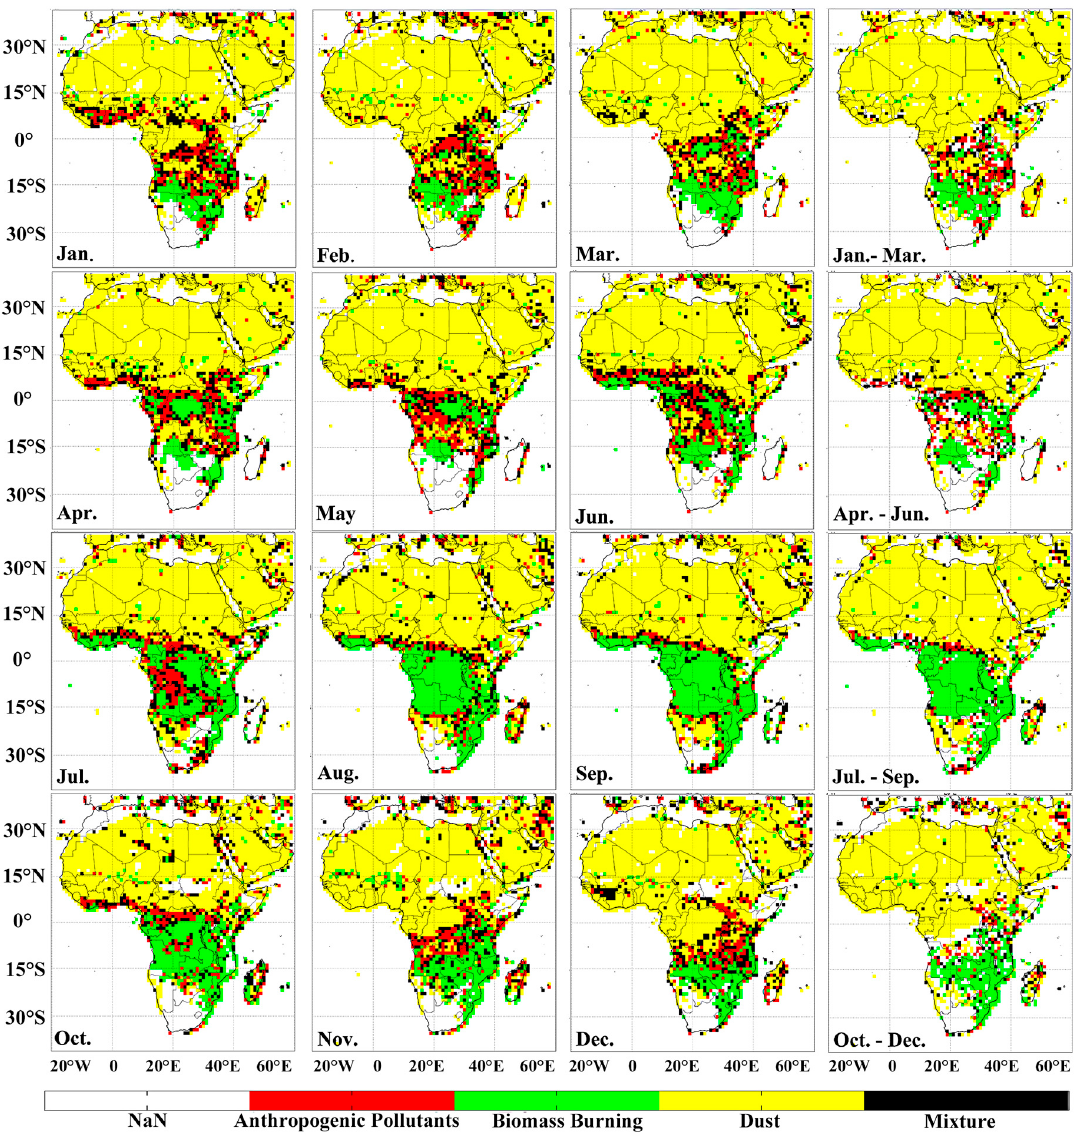
Figure 2. The spatial distribution of type aerosols from January to December 2015. The colors represent different PM 2.5 types: green (biomass burning), red (anthropogenic), yellow (dust), and black (mixture).